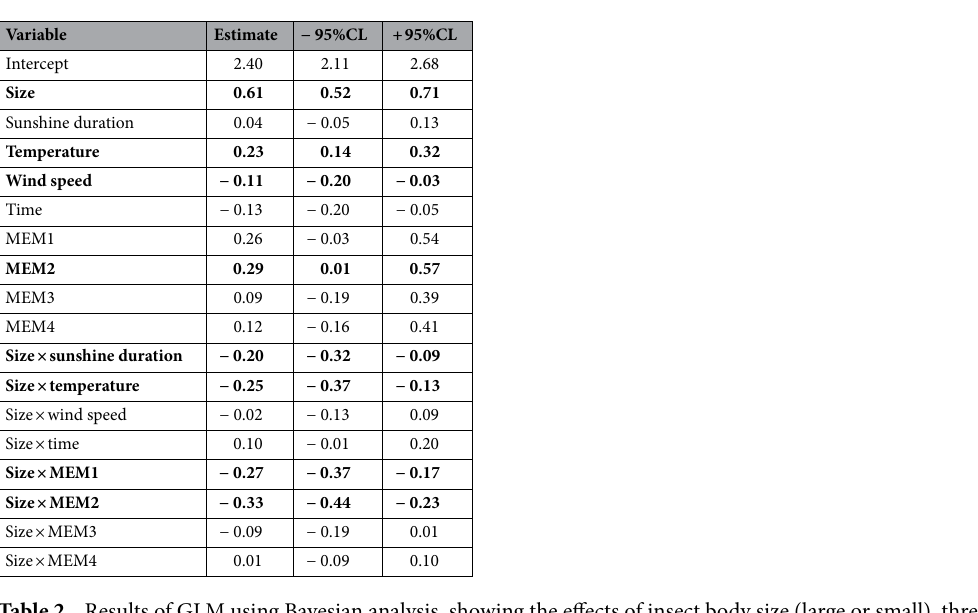
Table 2. Results of GLM using Bayesian analysis, showing the effects of insect body size (large or small), three weather variables, and four spatial variables on the abundance of insects visiting buckwheat flowers. Spatial variables were represented by four MEM axes (Moran’s Eigenvector Map). The variables with bold lettering indicate their 95% credible interval do not overlap with